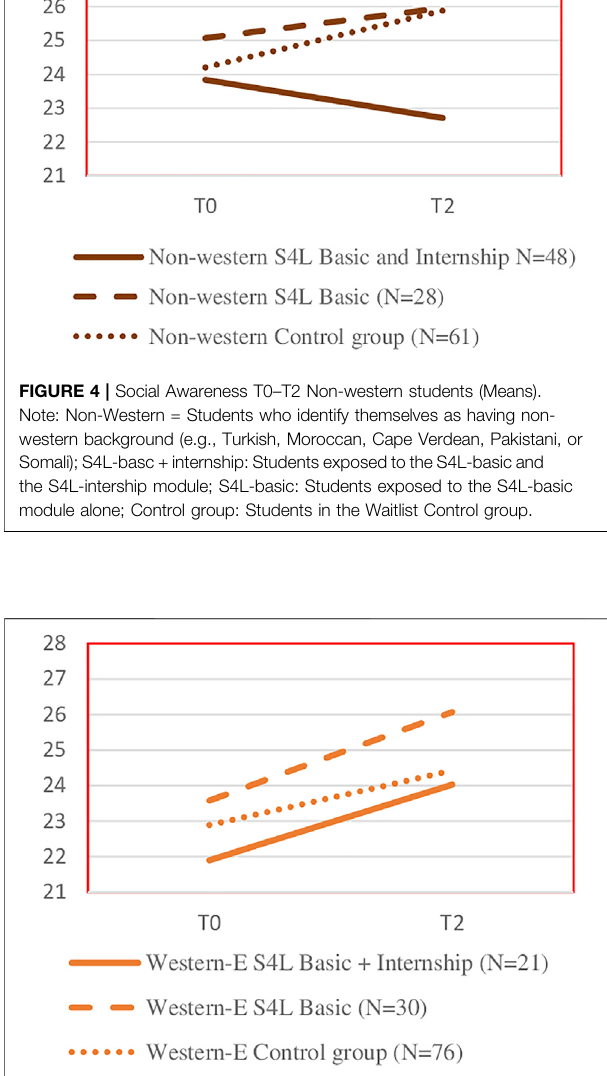
FIGURE 5 | Social Awareness T0 – T2 skills Western-E students (Means) Note: Western-E (cid:1) Students who identify themselves as having western background (e.g., Dutch, Belgium or German) S4L-basc + internship (cid:1) Studentsexposed tothe S4L-basic and theS4L-intership module; S4L- basic (cid:1) Students exposed to the S4L-basic module alone; Control group (cid:1) Students in the Waitlist Control